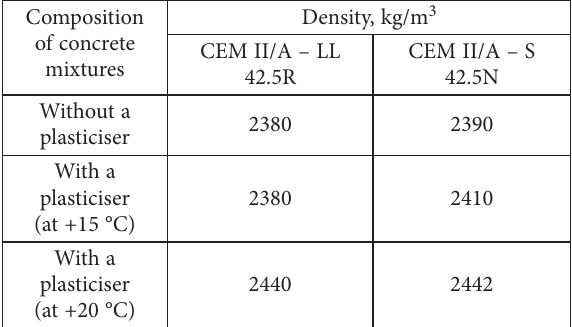
Table 6. The density of concrete mixtures with different